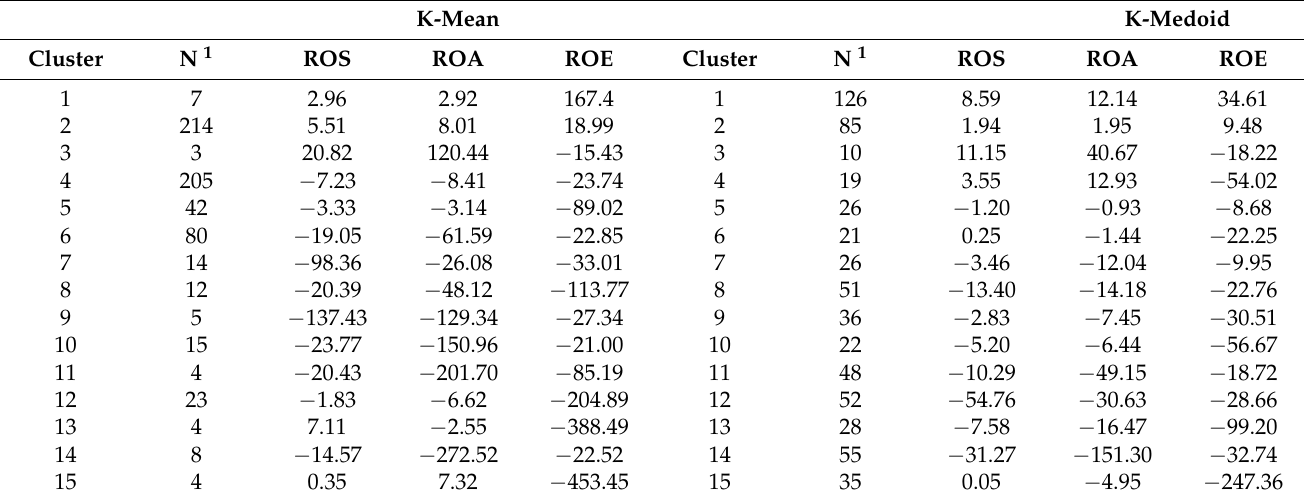
Table 7. Average financial indicator values per cluster (%) for Romanian companies.